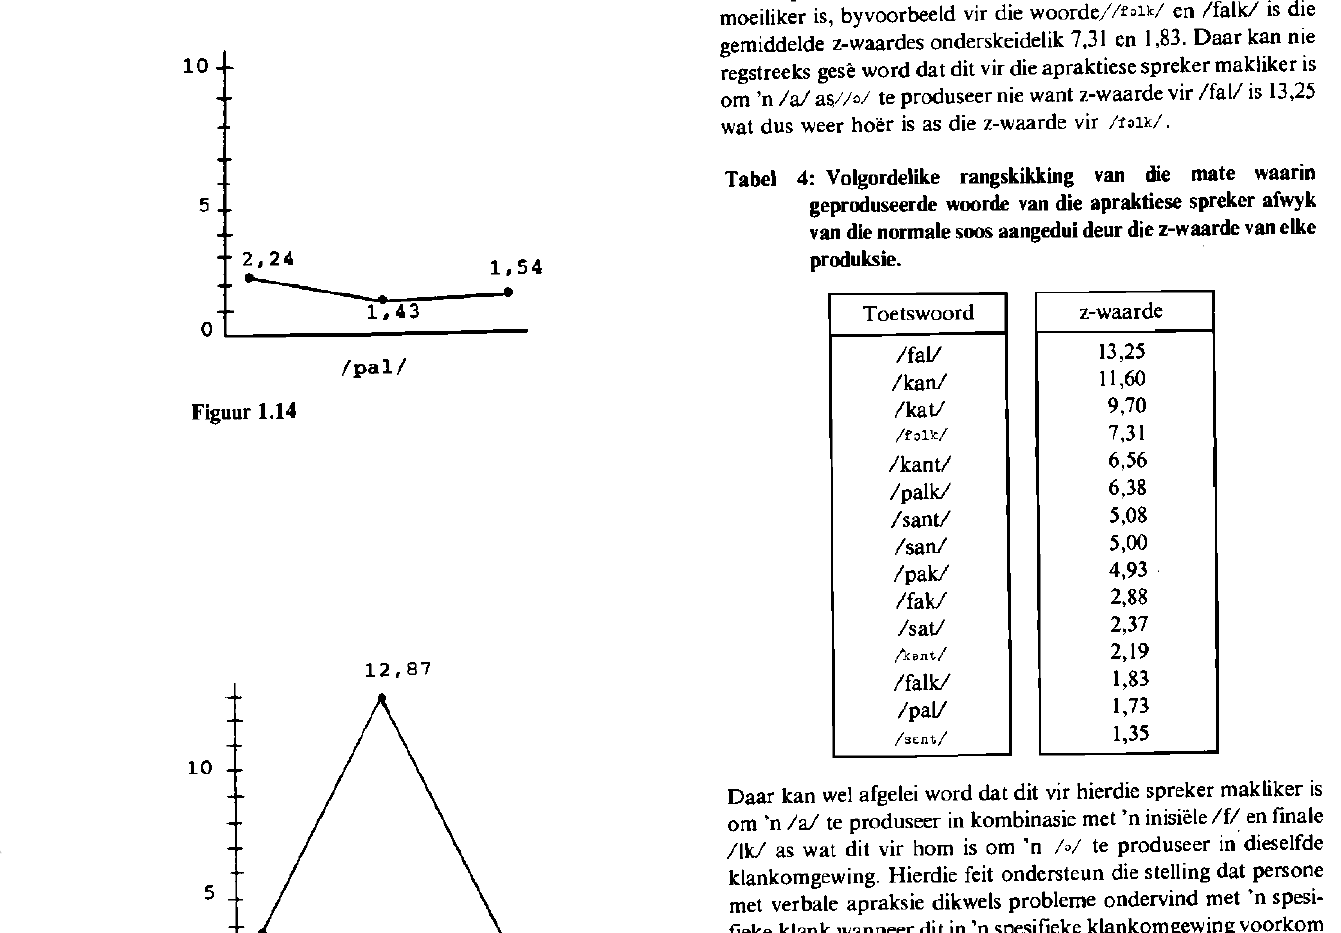
Tabel 4: Volgordelike rangskikking van die mate waarin geproduseerde woorde van die apraktiese spreker afwyk van die normale soos aangedui deur die z-waarde van elke